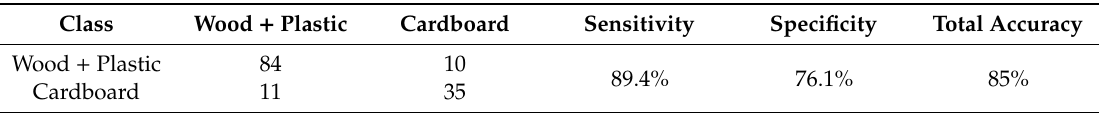
Table 6. DSVM classification performance for classifying wood vs. plastic using LOO cross-validation. Class